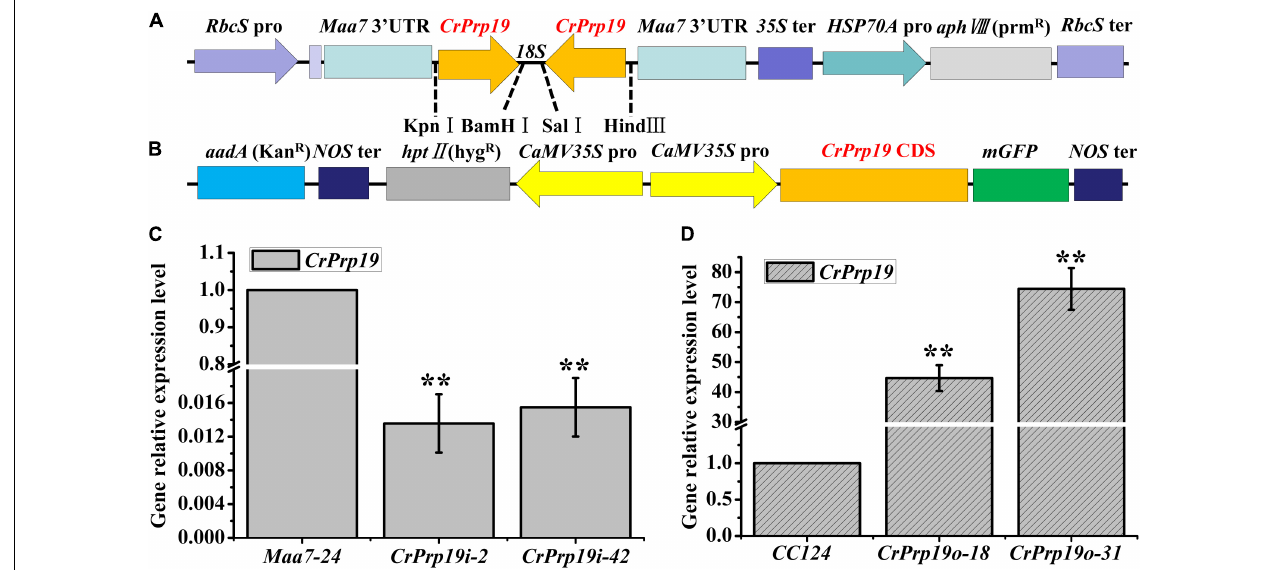
FIGURE 3 | Schematic illustration of CrPrp19 RNA interference and overexpression constructs and presentation of the resulting gene relative expression levels after transformation. (A) Schematic diagram of p Maa7 IR / CrPrp19 IR drawn according to Deng et al. (2011). (B) Schematic diagram of pCAMBIA1302/ CrPrp19 . (C) Gene relative expression levels of two CrPrp19 RNA silencing individuals during standard growth conditions; the values were normalized to the expression level of the empty vector p Maa7 IR transgenic line. (D) Gene relative expression level of CrPrp19 overexpression cell lines normalized to the expression level of the wild type; error bars indicate a standard error, asterisks (**) show significant differences at p < 0.01 compared with controls by one-way